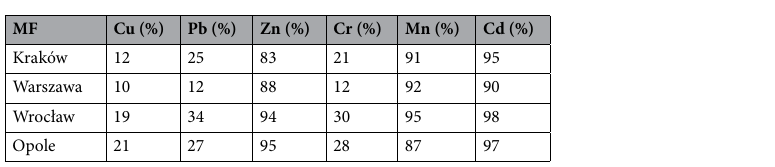
Table 4. Mobility factor (%)